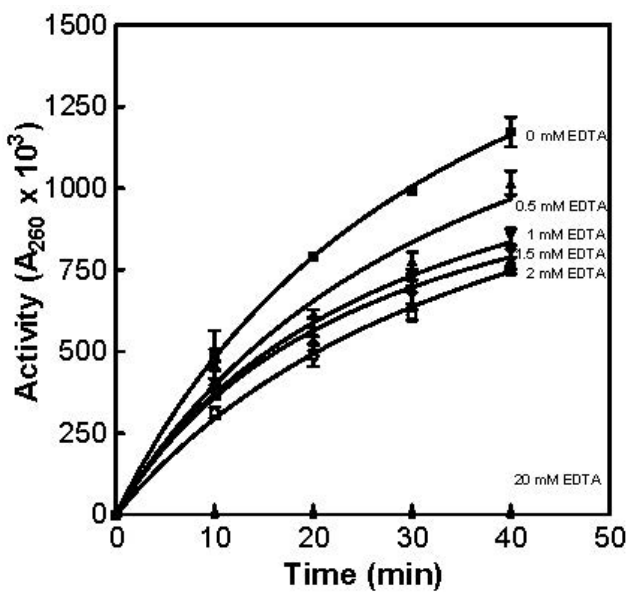
Figure 8. The effect of EDTA on partially purified RNase activity. The results were obtained using the acid soluble assay at 55 °C with the designated amount of EDTA added to the